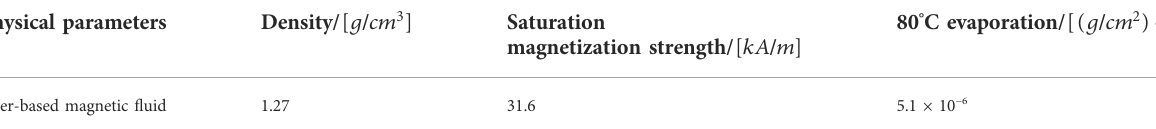
TABLE 1 Physical parameters of magnetic fl uid used in this article.